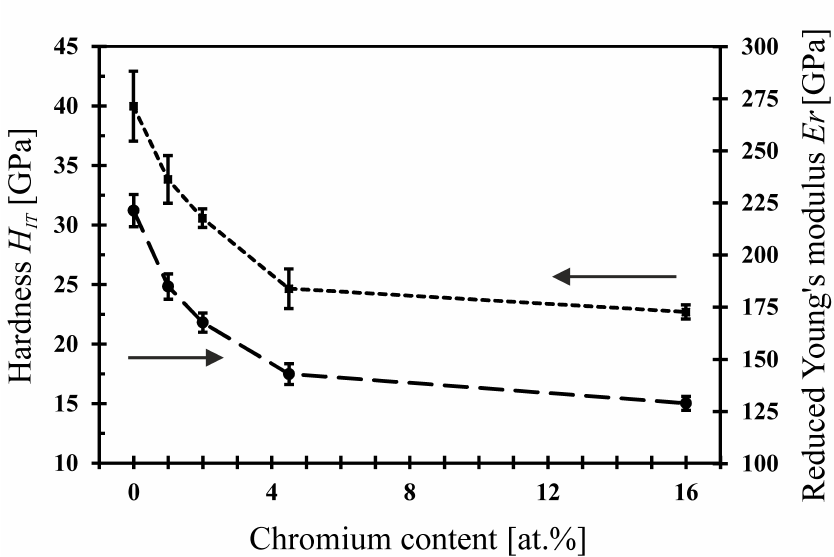
Figure 4. Hardness and reduced Young's modulus of the DLC and Cr-DLC films with various Cr contents.